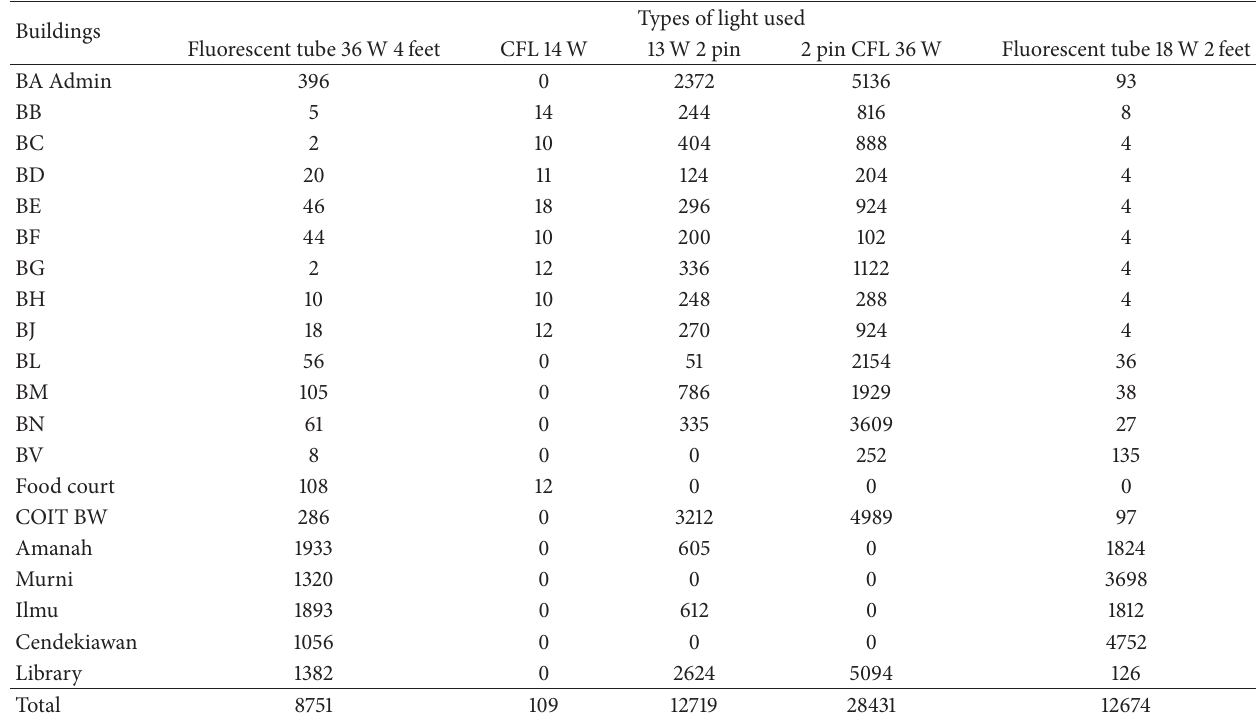
Table 3: Number of light collected for each building.